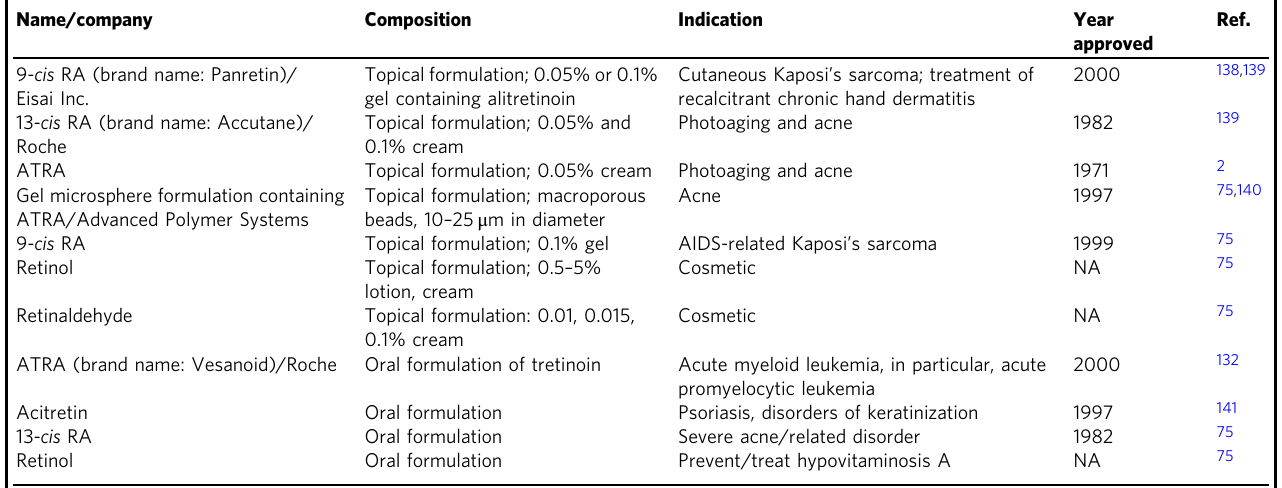
Table 4 Marketed RA